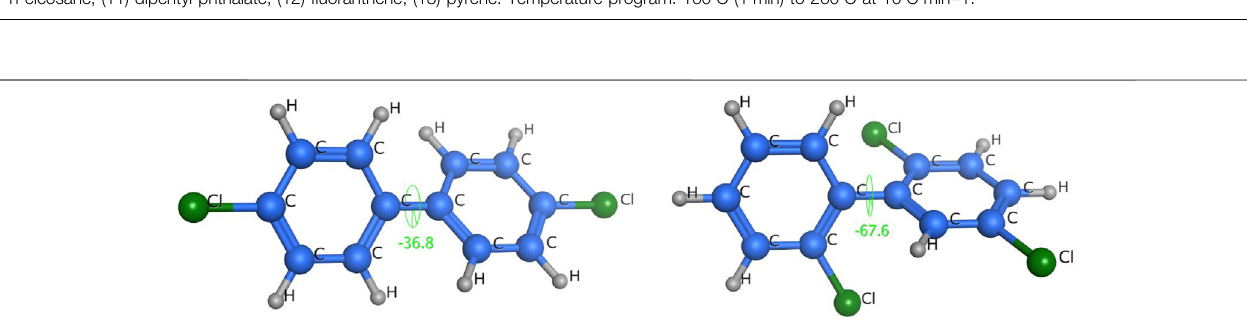
Frontiers in Chemistry |